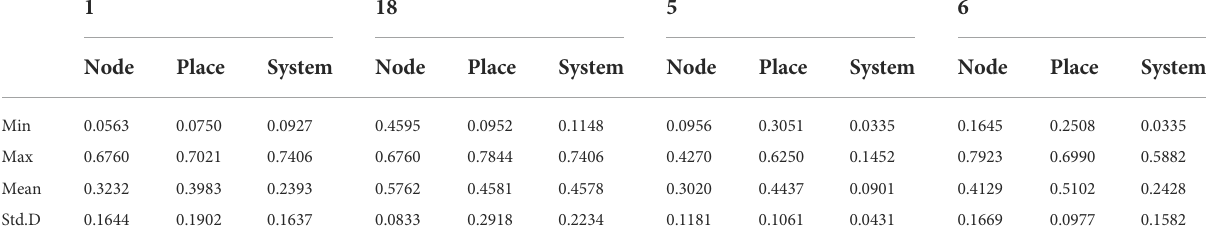
TABLE 7 Descriptive statistics of the node, place, and system support indexes of each metro